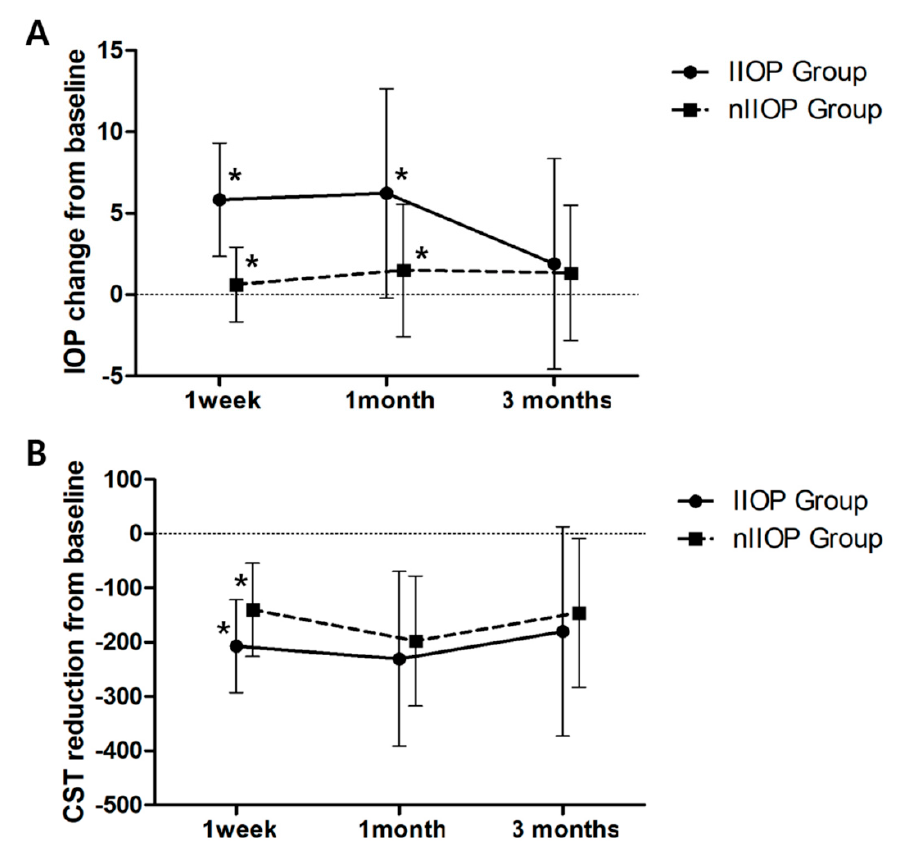
Figure 1. Graph illustrating changes in mean intraocular pressure (IOP) elevation and mean central subfield thickness (CST) reduction after intravitreal dexamethasone (DEX) implantation between the increase of IOP (IIOP) group and non-IIOP (nIIOP) group. ( A ) Mean IOP change. ( B ) Mean CST reduction. Asterisk (*) means significant difference between the groups.